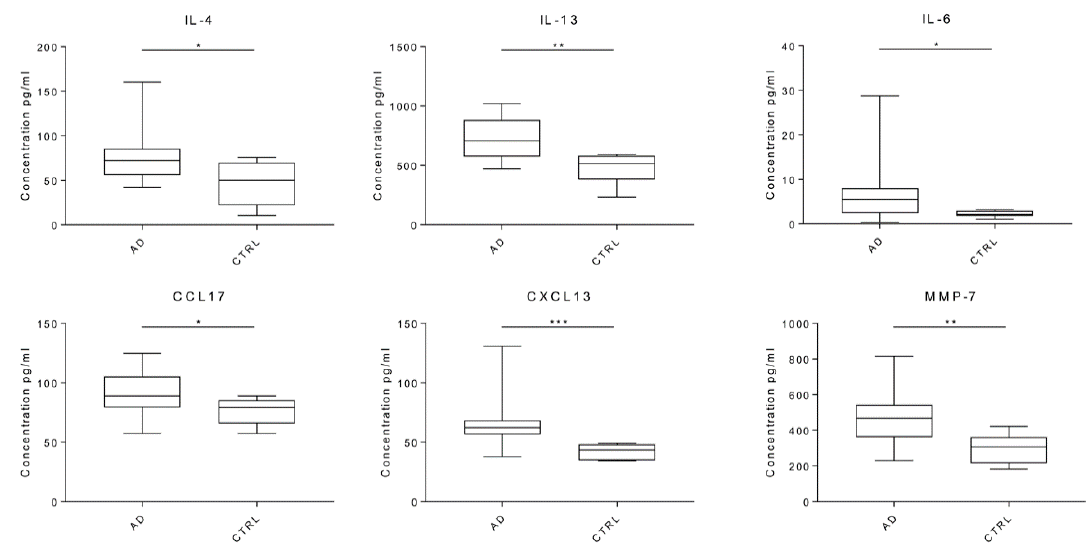
Figure 3. Comparison between AD and control samples. Boxplots of the most significant analytes, IL-4, IL-6, IL-13, CCL17, MMP-7, CXCL13. * p < 0.05, ** p < 0.005, *** p < 0.001. For IL-6 the most extreme observations have been omitted for a better graphical representation.